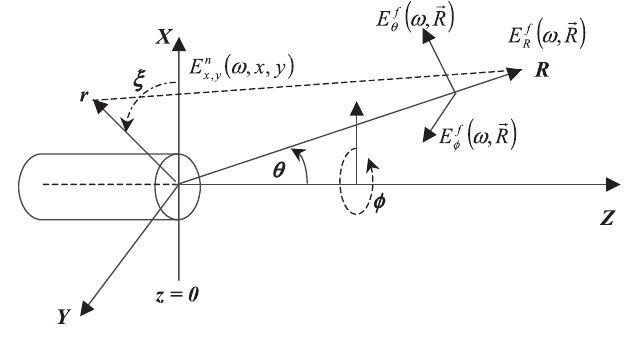
FIG. 2. Near-field — far-field